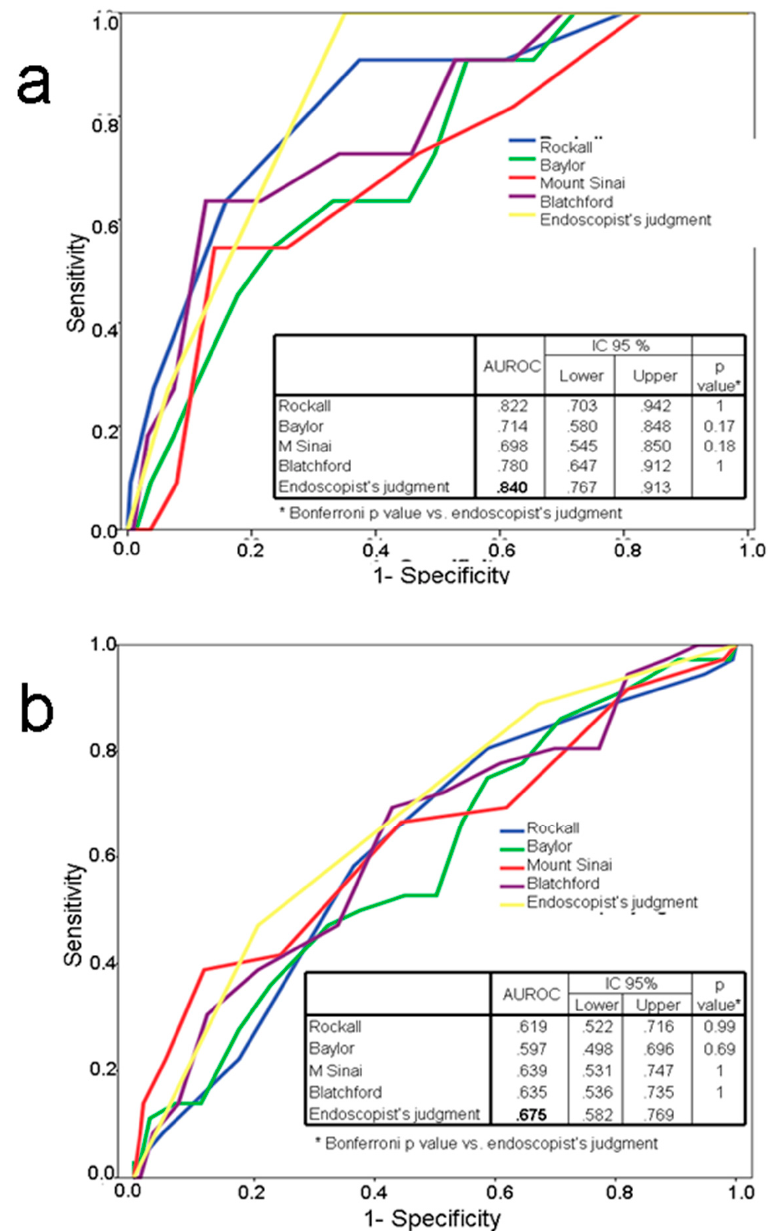
Figure 2. ( a ) Area under the ROC curve for mortality. ( b ) Area under the ROC curve for rebleeding. Endoscopically treated group.